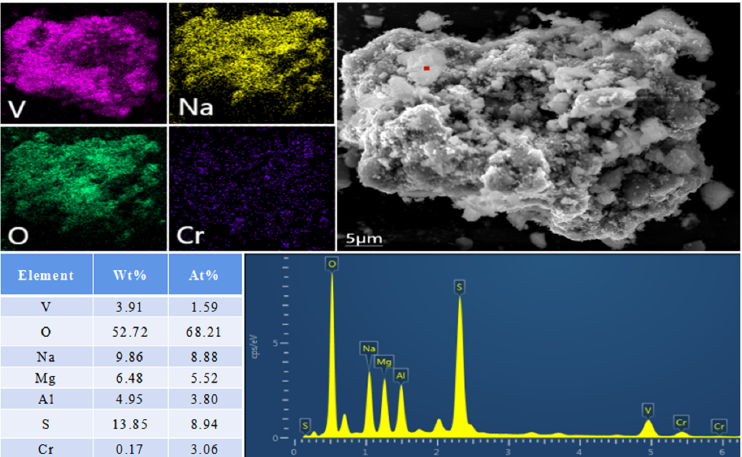
Figure 4. SEM–EDS characterization of the precipitate isolated from the acid leaching solution.